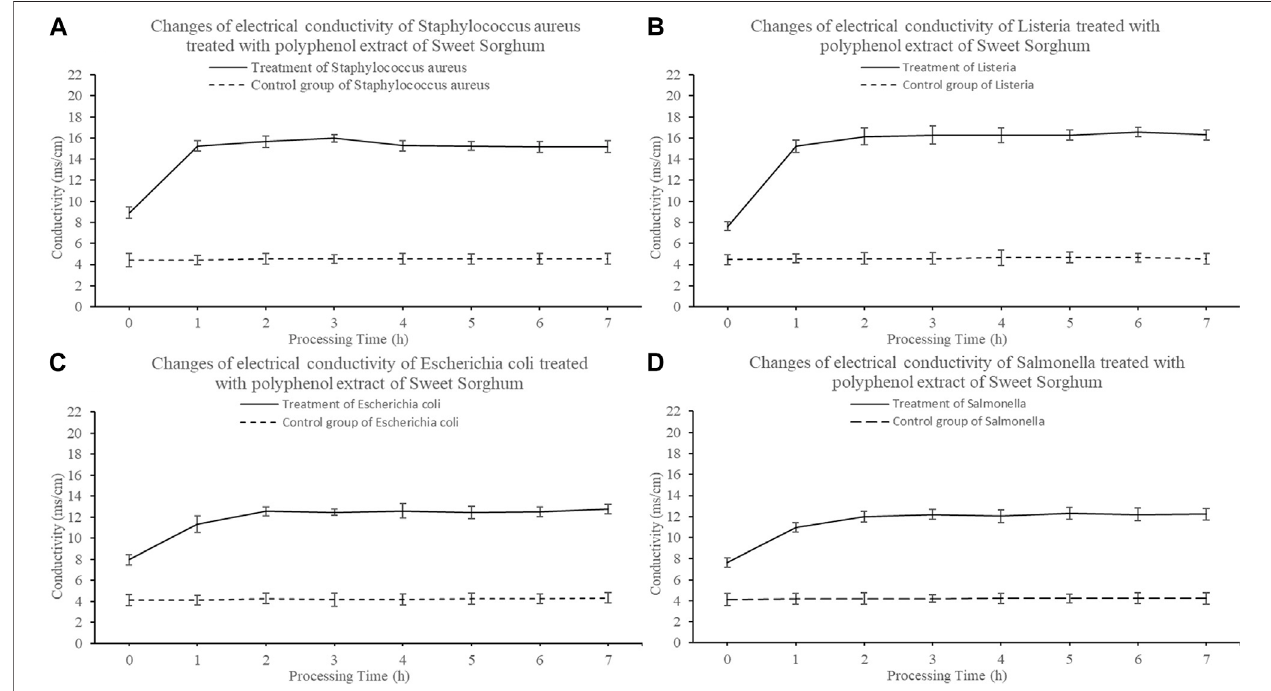
FIGURE 6 | Effect of polyphenols from sweet sorghum on electrical conductivity of pathogenic bacteria (A) is Staphylococcus aureus (B) is Listeria spp (C) is Escherichia coli (D) is Salmonella spp. The data are expressed as mean ± standard deviation. One-way ANOVA ( p < 0.001) and Dunnett ’ s posttest were used for statistical